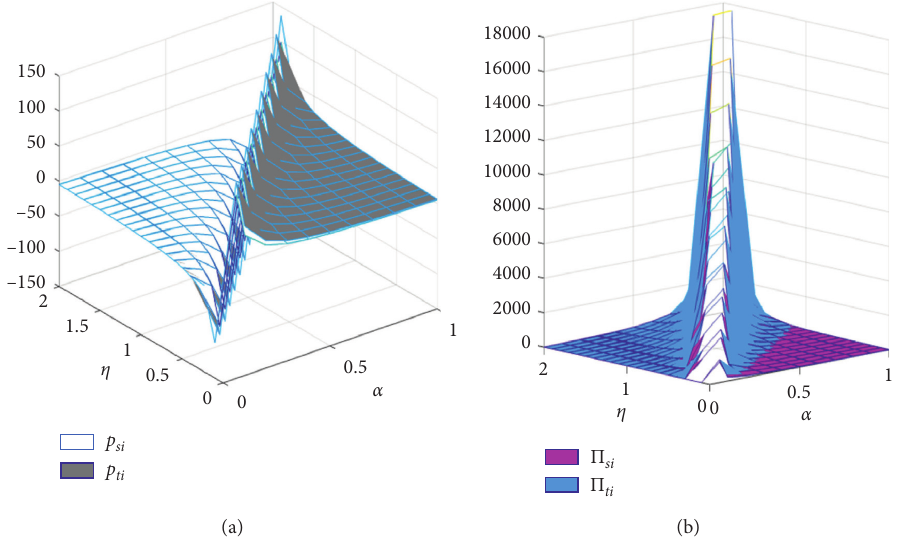
Figure 8: Price strategies and profits comparison. (a) p